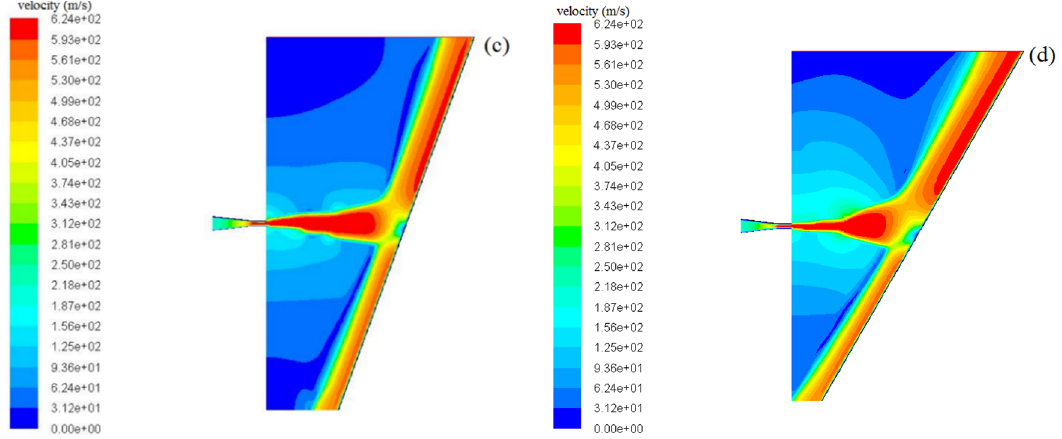
Figure 20. Predicted velocity cloud chart under various inclined angles ( a ) 0°; ( b ) 10°; ( c ) 20°; ( d ) 30°.